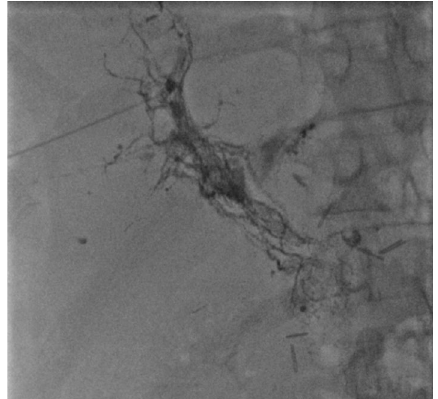
Fig. 3 Computed tomography after percutaneous transhepatic lymphangiography and embolization. Image showing accumulation of Lipiodol and n -butyl-2-cyanoacylate from the hepatic hilum to the hepatic lymphatic vessels (circle) and disappearance of ascites